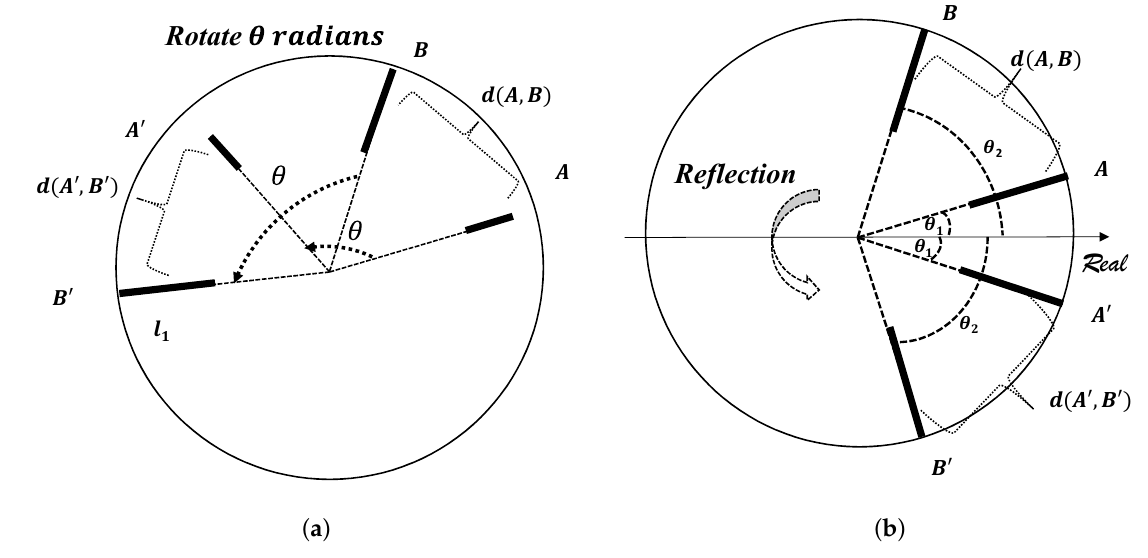
Figure 1. ( a ) reflectional invariance and ( b ) rotational